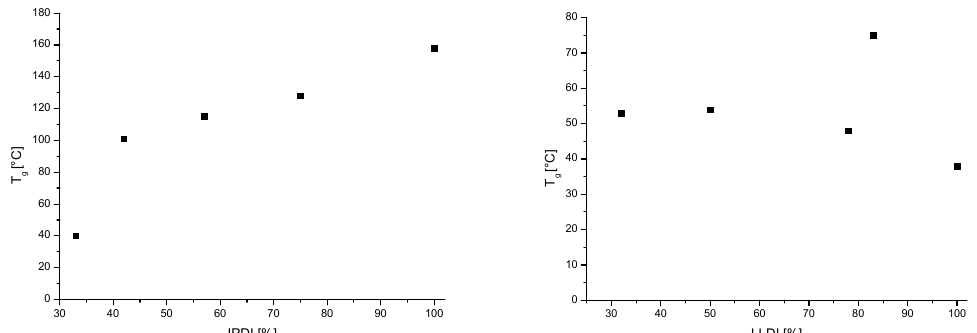
Figure 5. Relationship between T g and isocyanate ratio of IPDI-based ( left ) and LLDI-based ( right ) PU films.